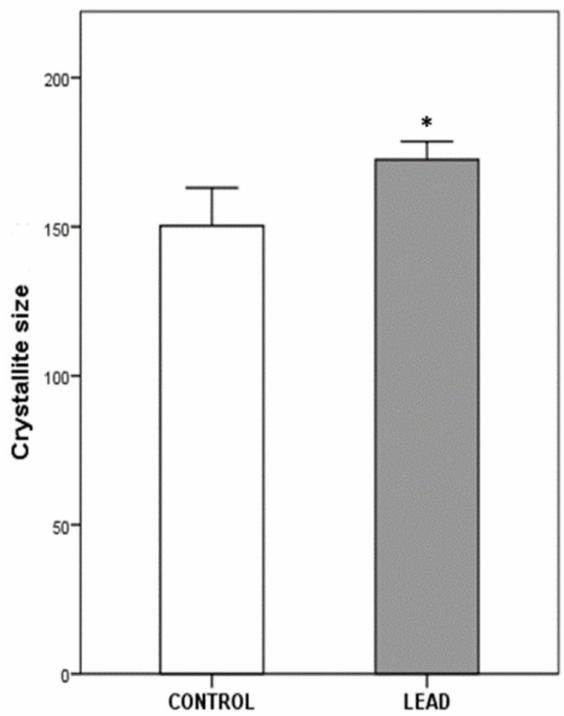
Figure 4. Crystallite size measurements of apatite crystals in the alveolar bone of the control ( n = 5) and lead exposure ( n = 8) groups. Values (Å) are expressed as means ± S.E.M. Asterisk indicates statistical differences between groups ( p <